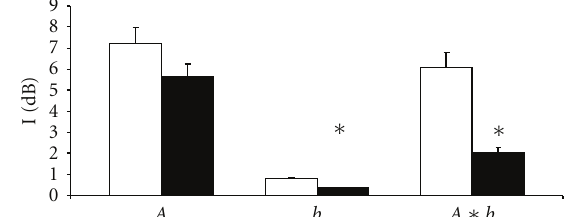
∗ P < . 01 compared to basal time). The circumferential and radial strain were obtained in the parasternal short- axis view. Apical views were used to measure longitudinal strain as well as in the anterior, lateral, and inferior